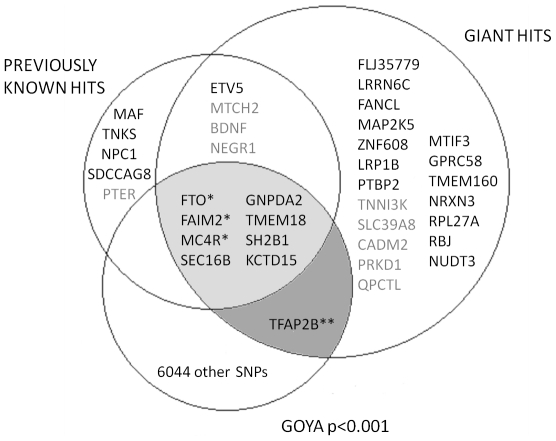
The overlap of previously known BMI hits, GIANT BMI hits and GOYA results.Shown are the loci with p<0.0001 in the current GOYA study (that were taken through to replication), the previously known BMI hits [1], [2], [11] and the recent GIANT BMI hits [3]. The light grey shaded area shows the loci which had p<0.001 in GOYA, but were excluded from replication because there was already strong evidence for an association with BMI and the dark grey shaded area shows the TFAP2B loci which we included in our replication stage (as it had not been identified in previous studies) and found genome-wide significant evidence for its association with BMI, and since our replication stage it has been identified as associated with BMI in the GIANT study. The grey previously associated loci had p<0.05 in GOYA. *p<5×10−8 in GOYA discovery analysis, ** p<0.001 in GOYA discovery & replication meta-analysis.